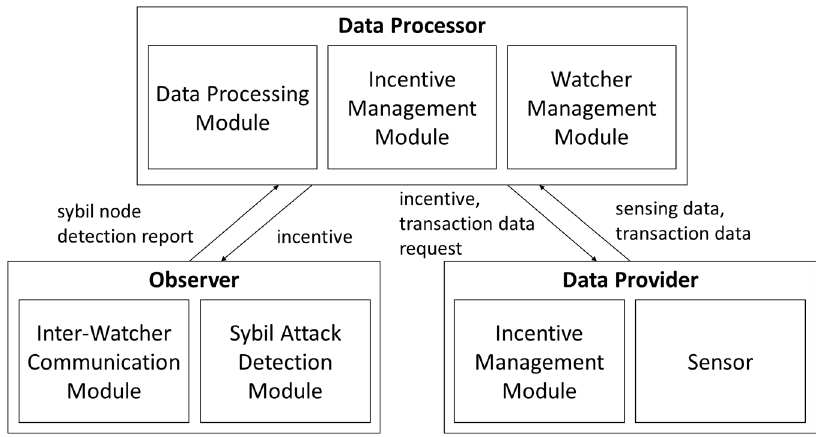
Figure 3. Proposed system structure.